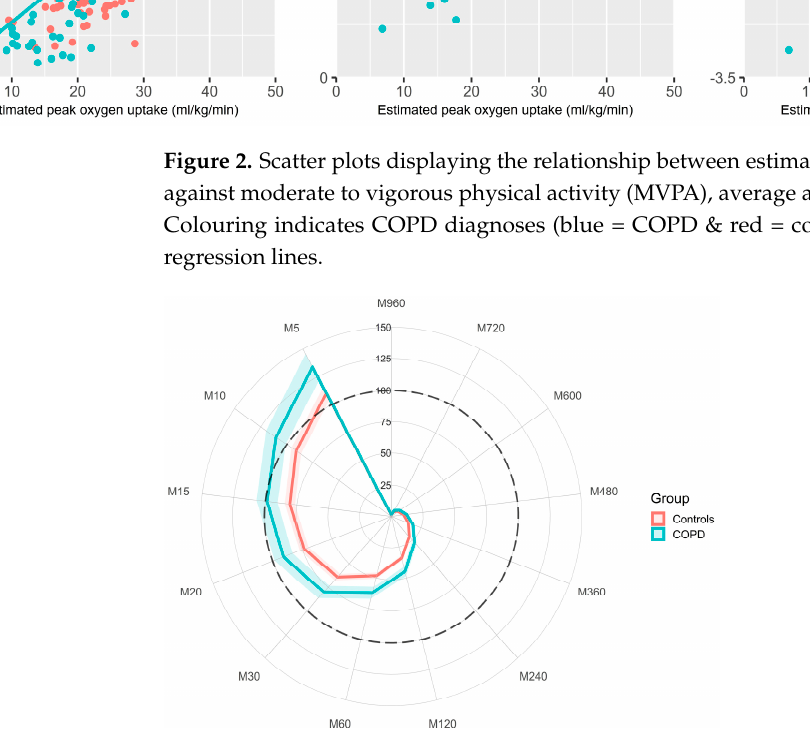
Figure 2. Scatter plots displaying the relationship between estimated peak oxygen uptake (VO 2peak ) against moderate to vigorous physical activity (MVPA), average acceleration and intensity gradient. Colouring indicates COPD diagnoses (blue = COPD & red = control) and lines represents linear regression lines.